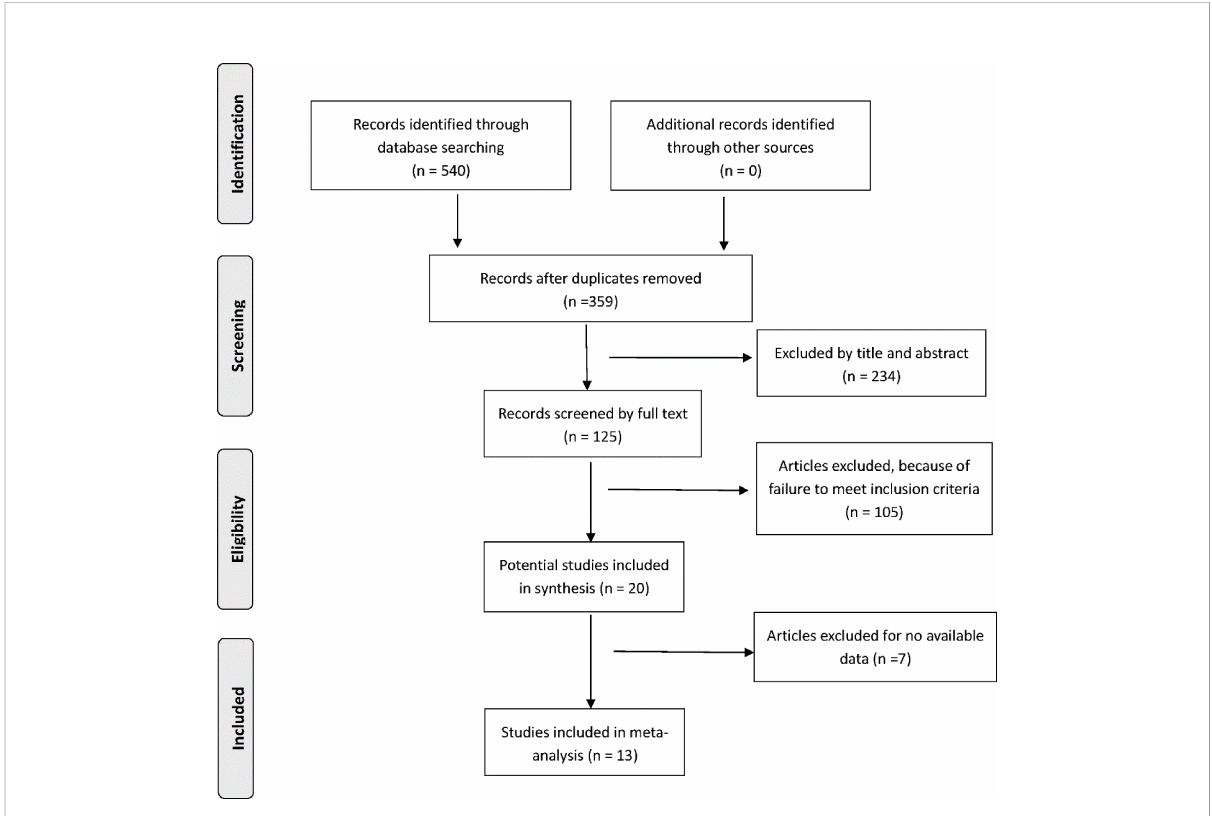
FIGURE 1 Flowchart for the identi fi cation of eligible